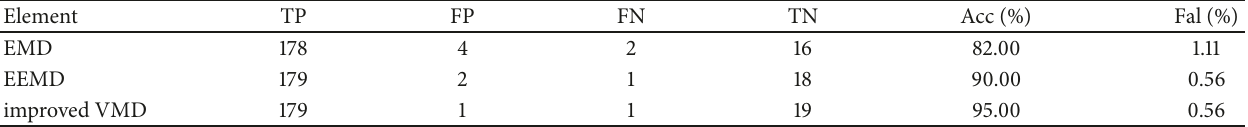
Figure 19: Decomposition result and corresponding spectrum by improved VMD. Table 4: Detection rate and error rate for actual data.